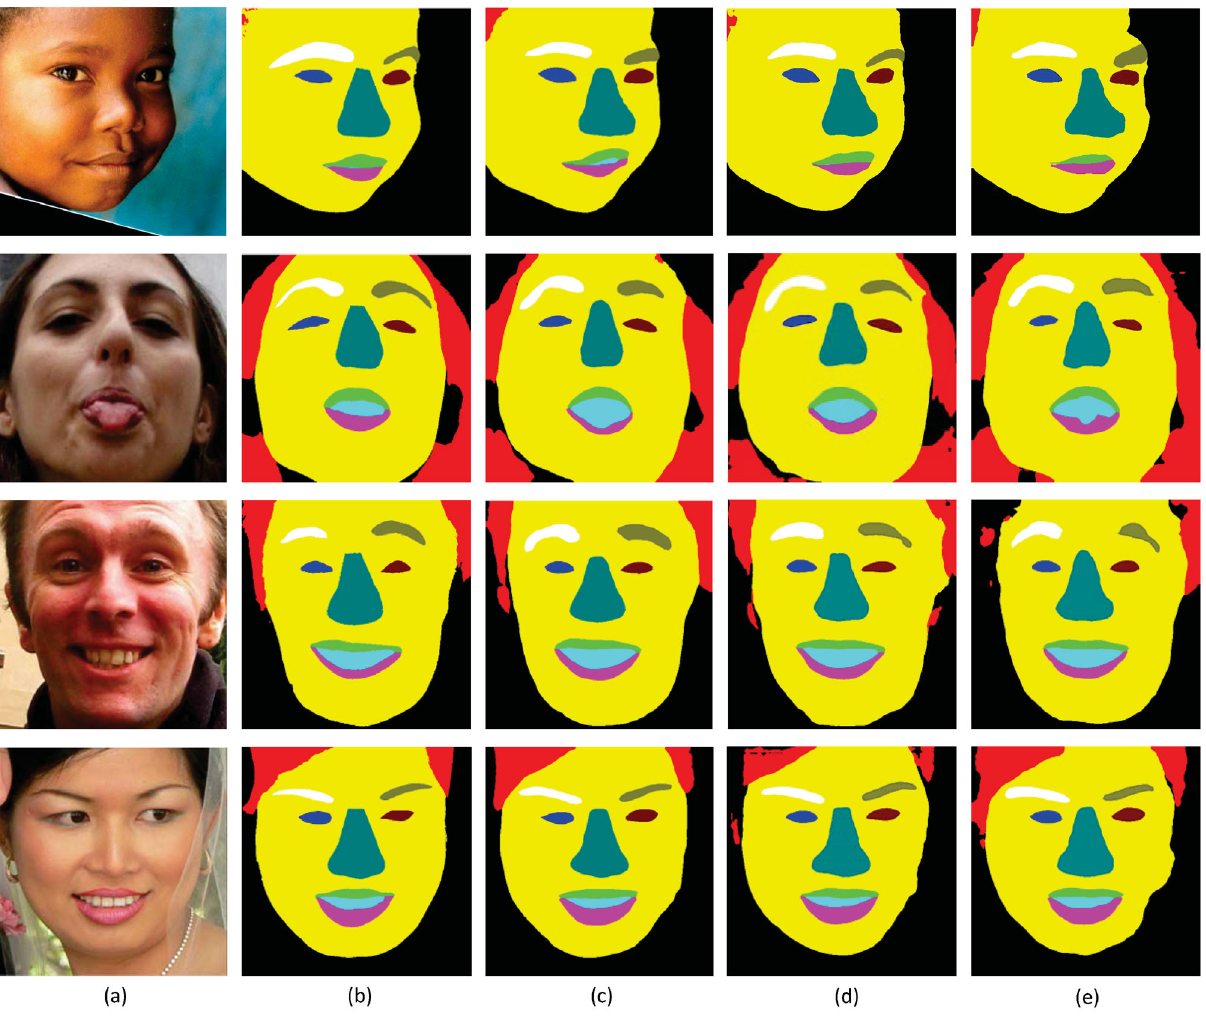
Fig. 2 Face parsing results for the Helen dataset. (a) Original images. (b) Ground truth. (c) Baseline model with dilation value of 4 (with best manually selected receptive field). (d) Modified model with initial dilation value of 12. (e) Baseline model with dilation value of 12. (d) and (e) show the improvements brought by our method. Smaller semantic areas have better parsing results, especially eyebrows , nose . Face boundaries are smoother and more accurate. (c) and (d) show that our models have very similar ability to manually designed models: our method can replace manual receptive field design